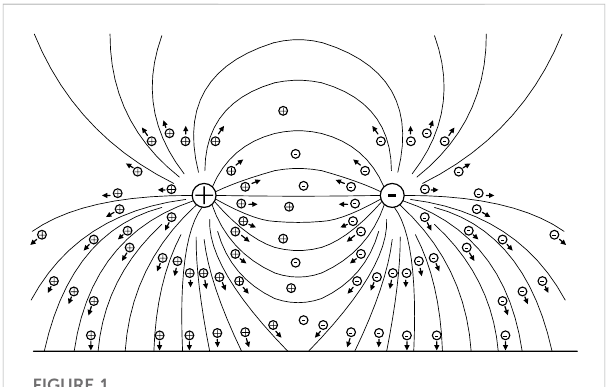
FIGURE 1 Schematic diagram of the ionized fi eld of bipolar direct-current transmission